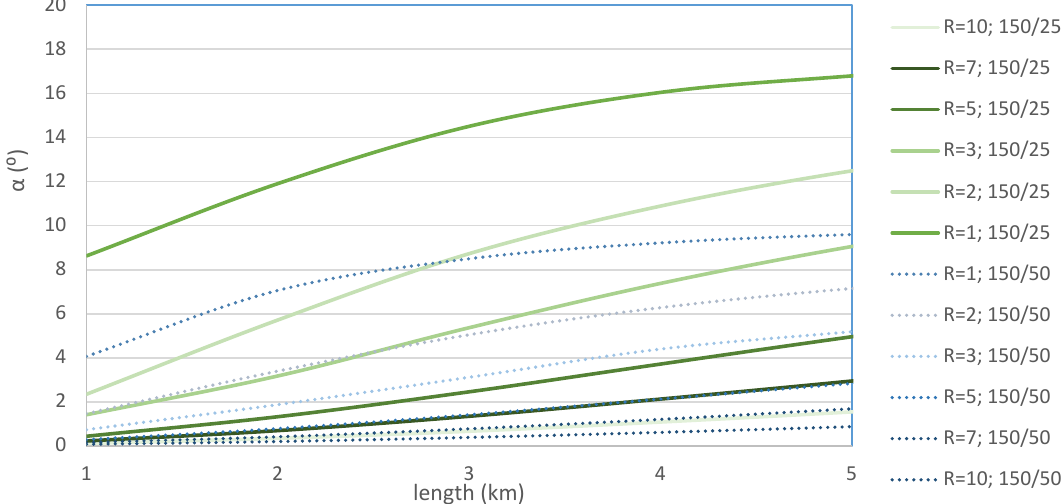
Figure 10. α for faults between cable core and screen at the end of cable line in a trefoil configuration.